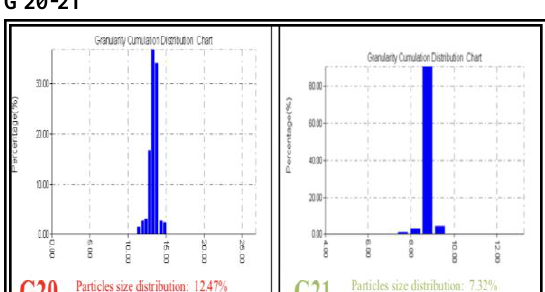
Figure 13. AFM 3D image of gold nanoparticles G20-21